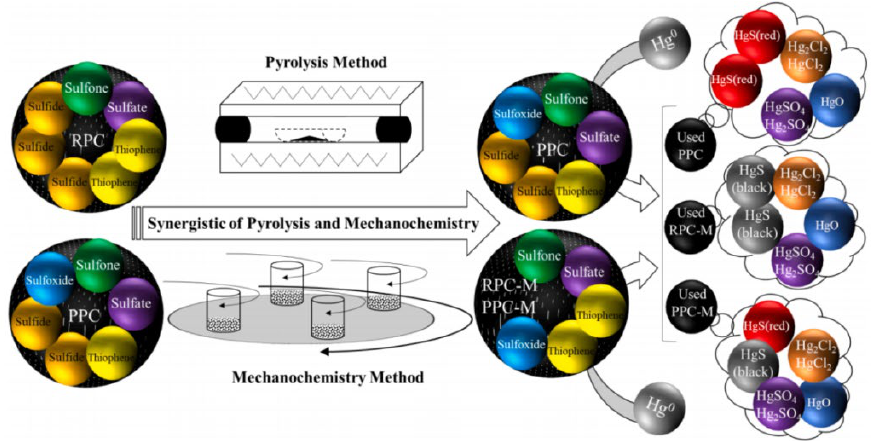
Figure 4. Activation and mercury removal mechanisms of RPC, PPC, RPC-M, and PPC-M [34]. Reprinted/adapted with permission from Ref. [34]. 2022, Chemical Engineering Journal.